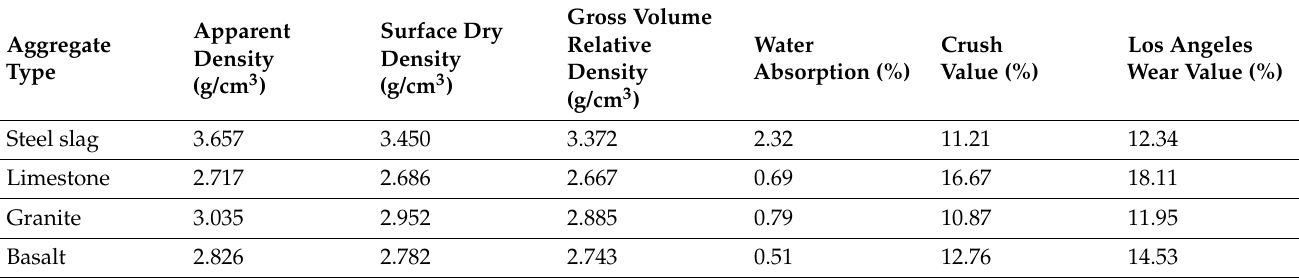
Table 1. Mechanical and physical properties of different